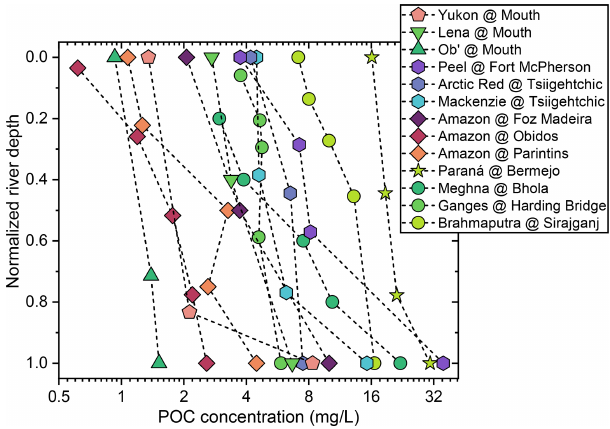
Figure 5. POC concentration variation in vertical water columns from depth profiles in global large rivers. Selected depth profiles are from the Yukon, Lena, and Ob’ (Holmes et al., 2022), Macken- zie including Peel and Arctic Red (Hilton et al., 2015), Amazon (Bouchez et al., 2014), Paraná (Repasch et al., 2021), and Ganges– Brahmaputra–Meghna systems (Galy et al., 2007, 2008b). Normal- ized river depth is calculated by normalizing the individual sample depth to the maximum sample depth of the corresponding profile.